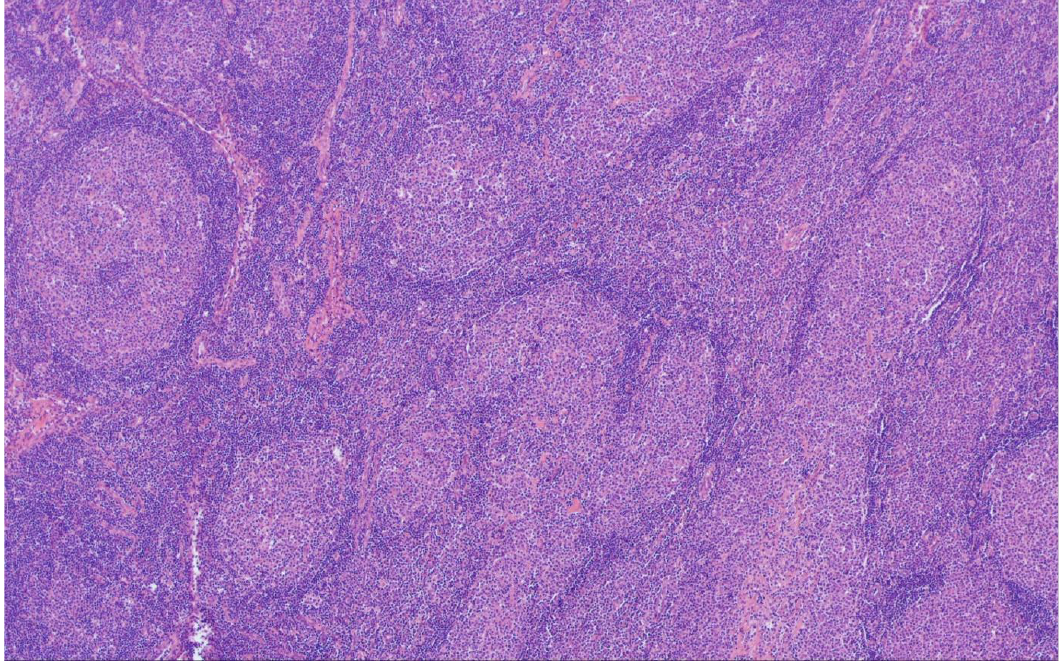
Figure 7. Pediatric-type follicular lymphoma (PTFL) (H&E ×100). In PTFL, there is an intriguing proliferation of large follicles, often lacking mantle zones, and that are large and expansile, often with a “ serpiginous ” growth pattern.